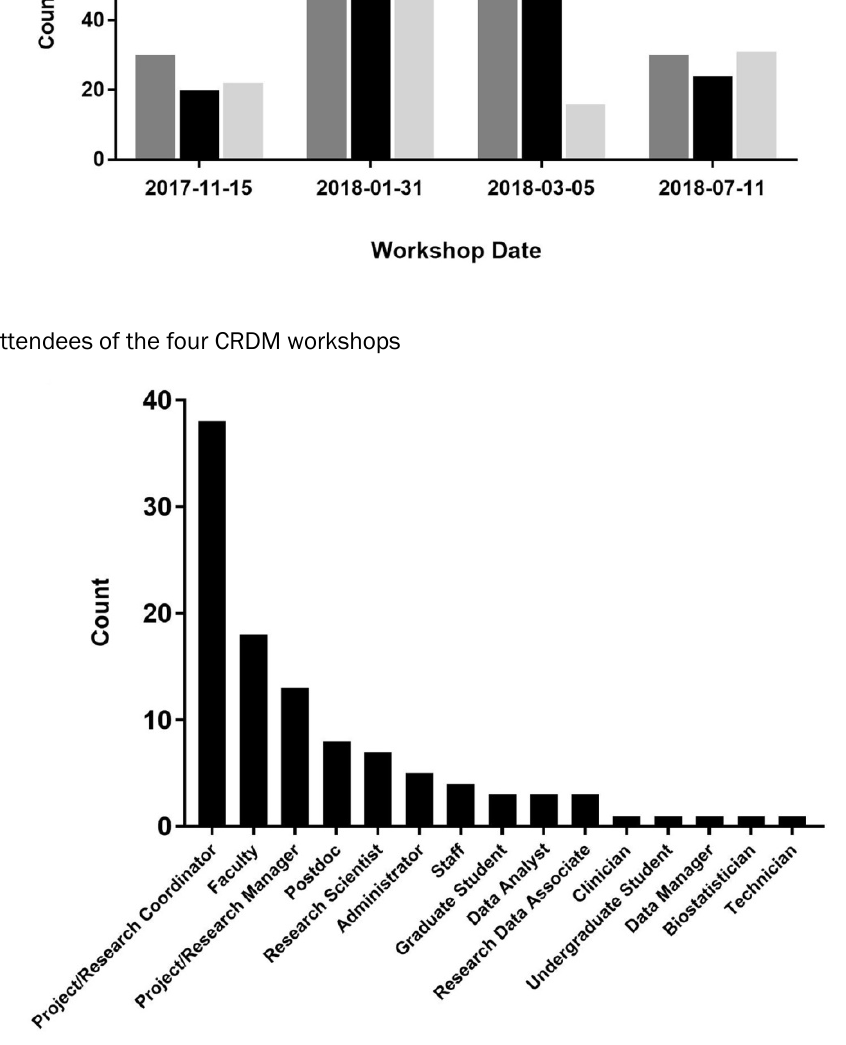
Research coordinators and project